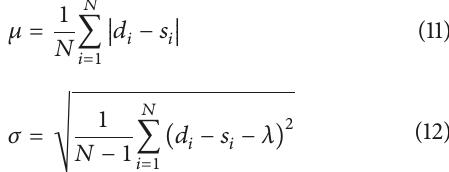
to (8), and denote the sampling point corresponding to the maximum value of the characteristic function as 𝑅